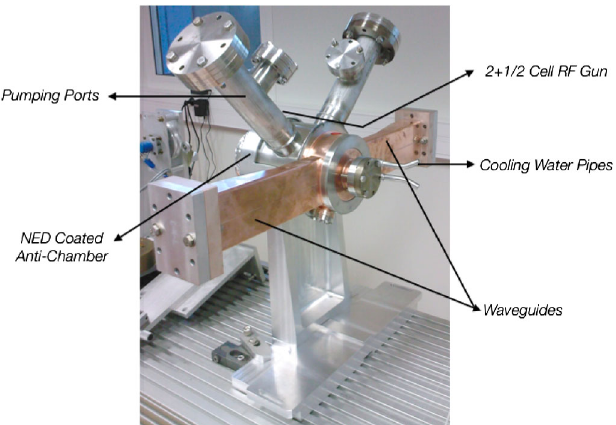
train.FIG. 3. The PHIN rf